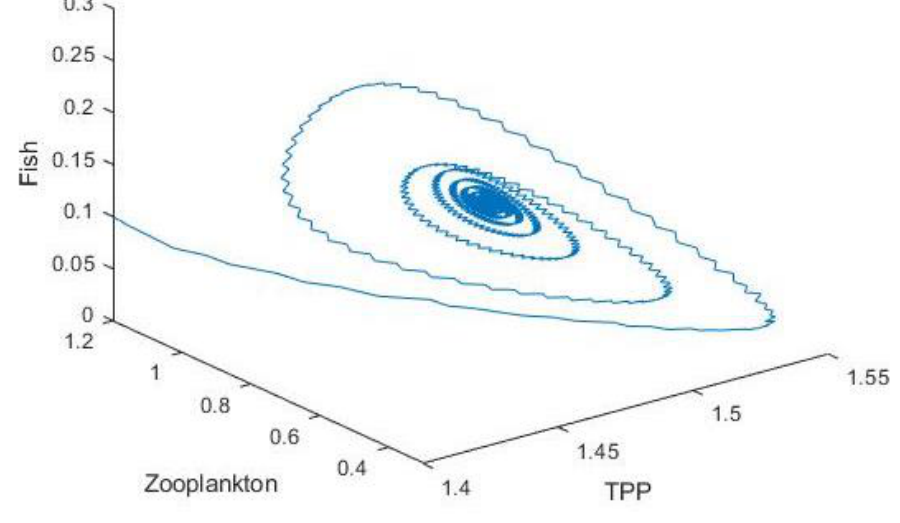
Figure 24. The asymptotical stability of all populations for τ = τ −